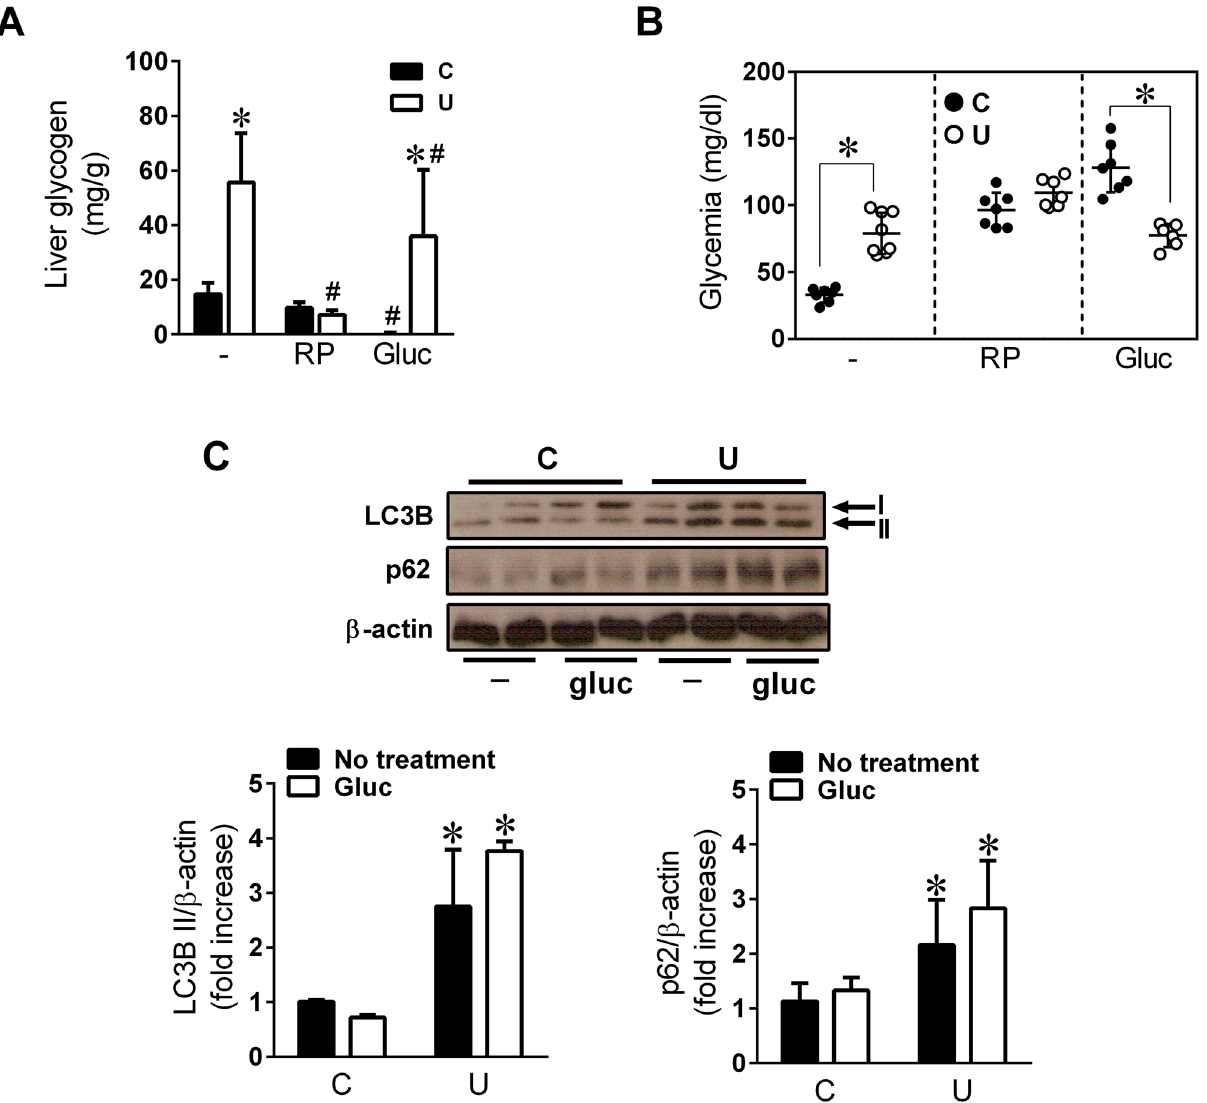
Figure 7. Glucagon treatment of U neonates fails to induce autophagy-dependent mobilization of liver glycogen. C and U neonates were treated or not with a single intraperitoneal dose of rapamycin (RP; 5 mg/kg) or glucagon (GN; 20 mg/kg) at birth and then 3 h-fasted (N3) before measurement of ( A ) liver glycogen content or ( B ) basal glycemia, n = 6–12. All values are mean ± SD. * p < 0.05 U versus C neonates within the same treatment. # p < 0.05 RP-treated or GN-treated versus untreated N3 neonates within the same nutritional condition. ( C ) Protein extracts from livers of C and U neonates at N3, RP- or GN-treated, were immunoblotted for autophagy markers LC3B and p62. Graphical bars represent densitometric quantification relative to β-actin protein levels from 4 individual animals per group. All values are mean ± SD. * p < 0.05 U versus C neonates under the same